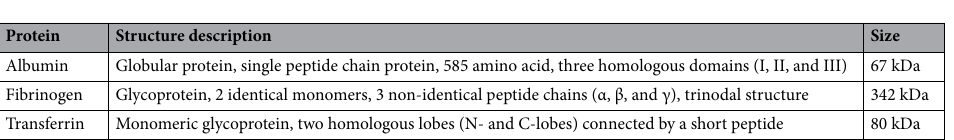
Table 1. Structure Description and Size of Major Human Serum Proteins.